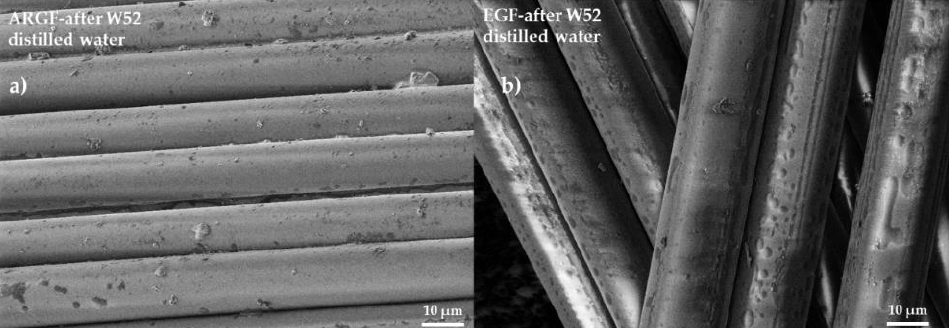
Figure 6. Surfaces of glass fibers treated with distilled water: ( a ) ARGF after W52, and ( b ) EGF after W52.